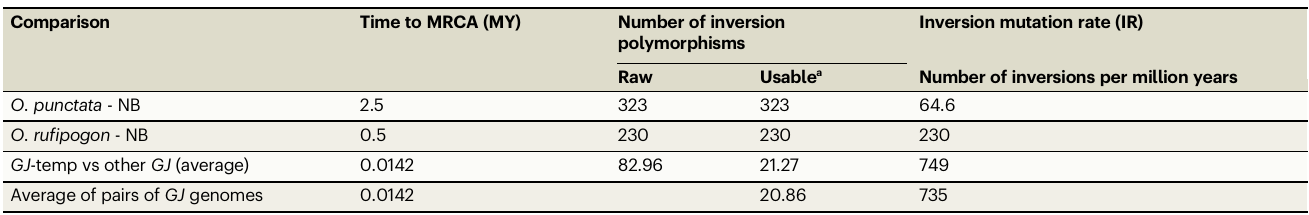
Table 2 | Inversion rate estimations